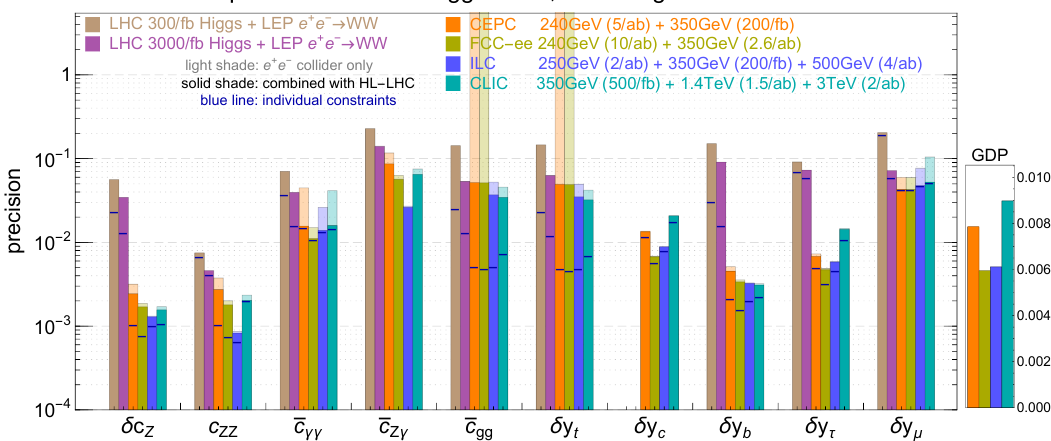
= (cid:14)(cid:20) (cid:13) = (cid:21) Z = 0, 1 ;Z 2 ) c ( g 2 + g g 0 2 ) c Z(cid:13) ZZ = 0 is 0 (cid:0) (cid:0)